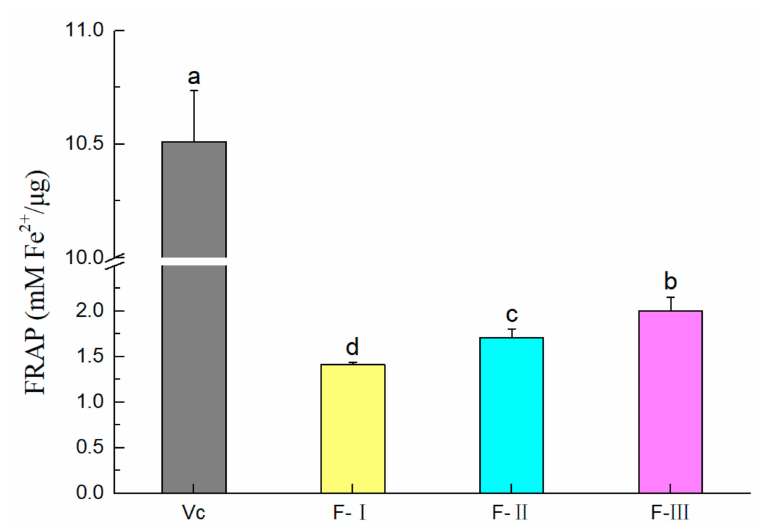
Figure 4. The ferric ion reducing antioxidant power (FRAP) abilities of three polyphenol fractions and vitamin C. Di ff erent letters (a–d) indicate significant di ff erences ( p <